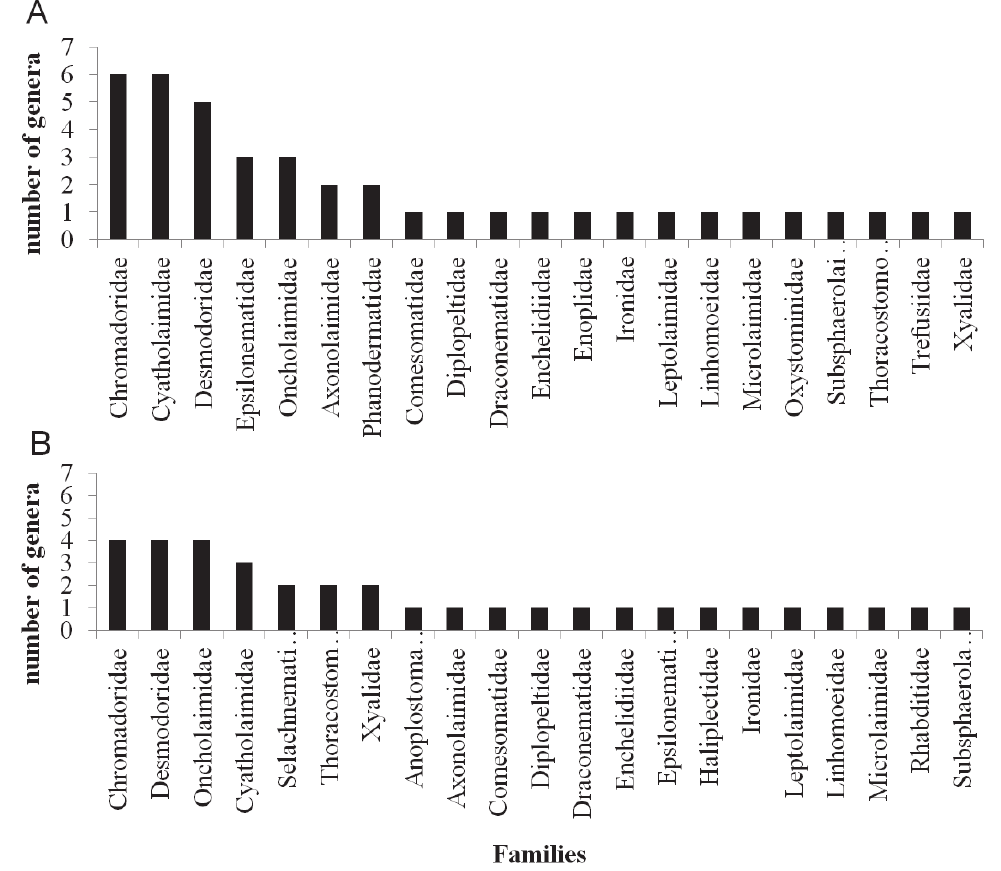
Fig. 3 - Number of genera per family found per beach. A: Coqueiros beach, B: Bananal beach.